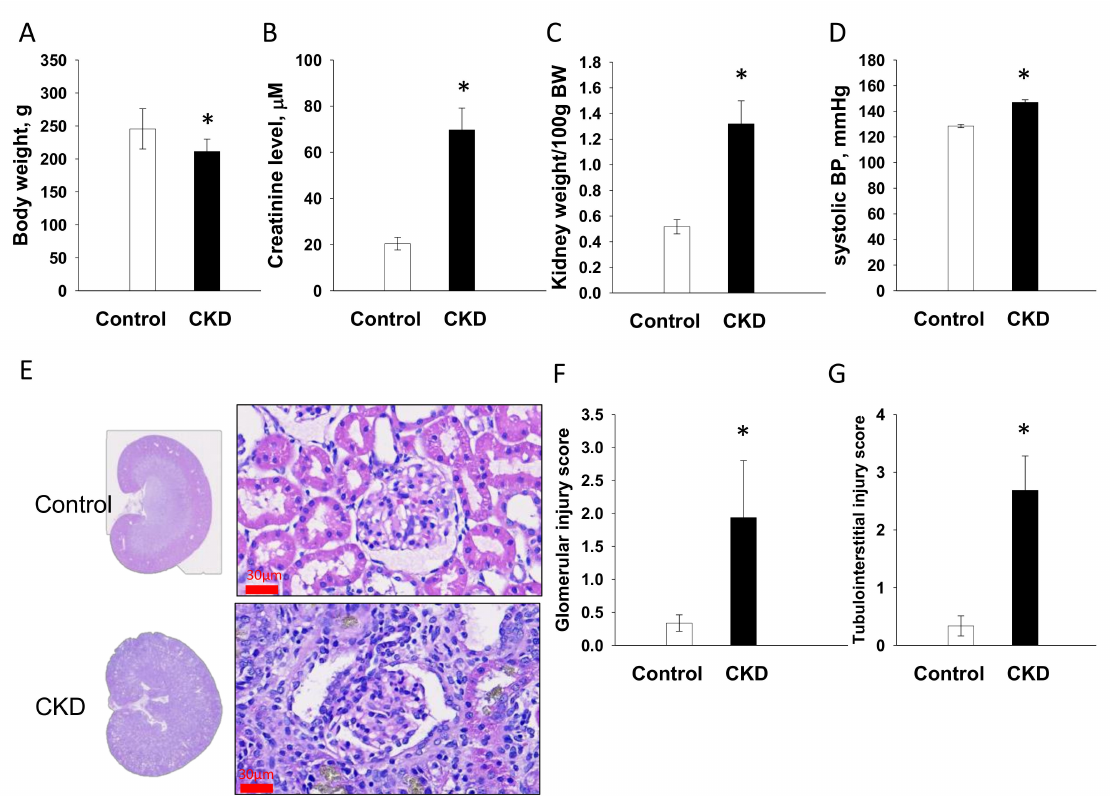
Figure 1. Renal outcome measures in mother rats. ( A ) Body weights, ( B ) plasma creatinine level, ( C ) kidney weight-to-body weight ratio, ( D ) systolic blood pressures, ( E ) periodic acid-Schi ff stained sections demonstrating renal histopathology of female rats fed with regular chow (control) or chow supplemented with 0.5% adenine (chronic kidney disease, CKD) for 3 weeks before pregnancy; scale bar = 30 µ m, ( F ) glomerular injury score, and ( G ) tubulointerstitial injury score. Data are shown as means ± SD; n = 8 / group. The asterisk indicates p < 0.05 vs.